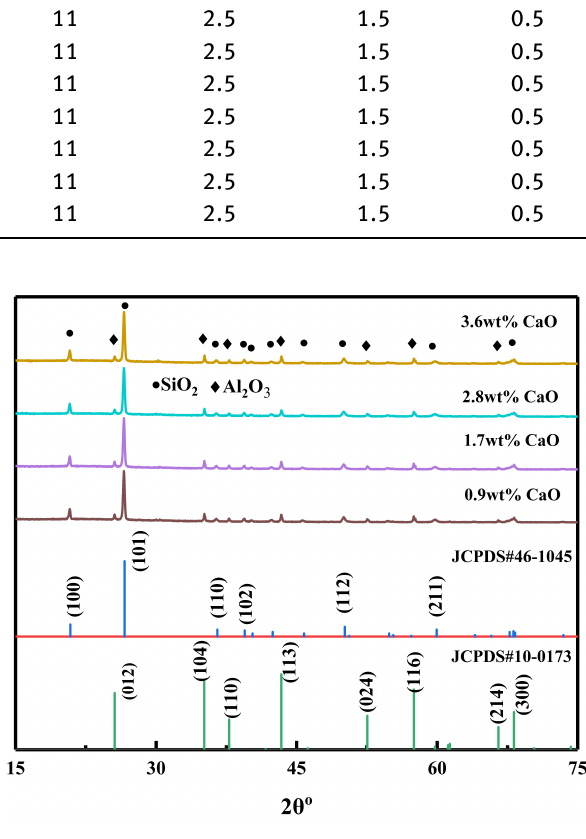
Figure 1: XRD patterns of samples with different CaO